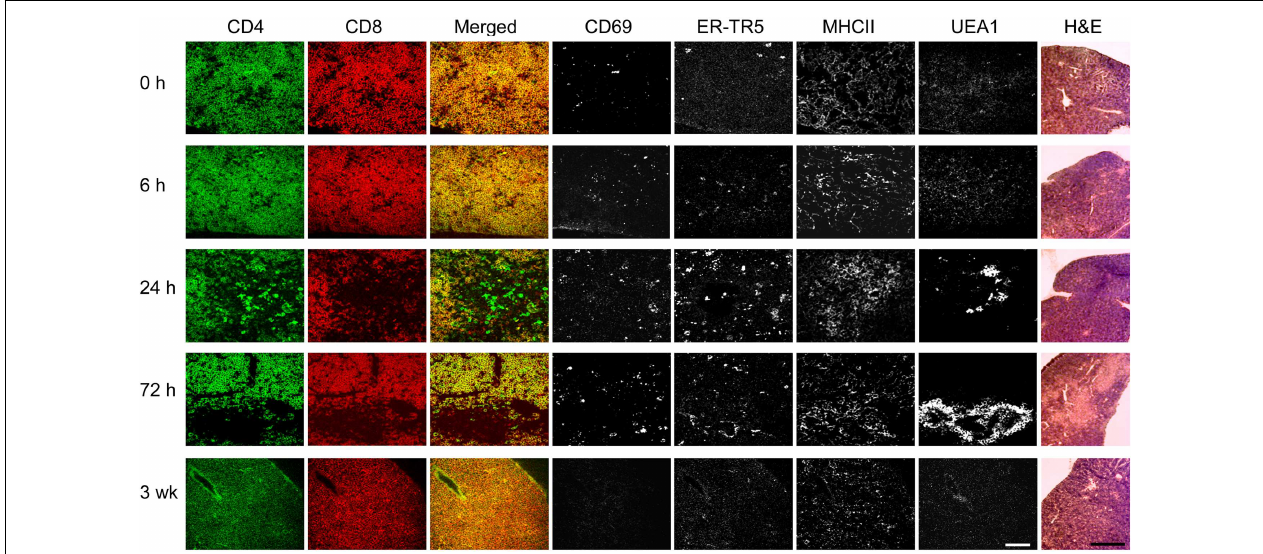
differentiate cortical from developing medullary structures, and with ER-TR5, UEA1, and anti-MHCII (I-A/I-E) to identify putative medullary elements. Five slides of each thymus were H&E stained.This experiment was repeated with identical results.White bar in the merged images represents 100 µ m and the black bar in the H&E panels represent